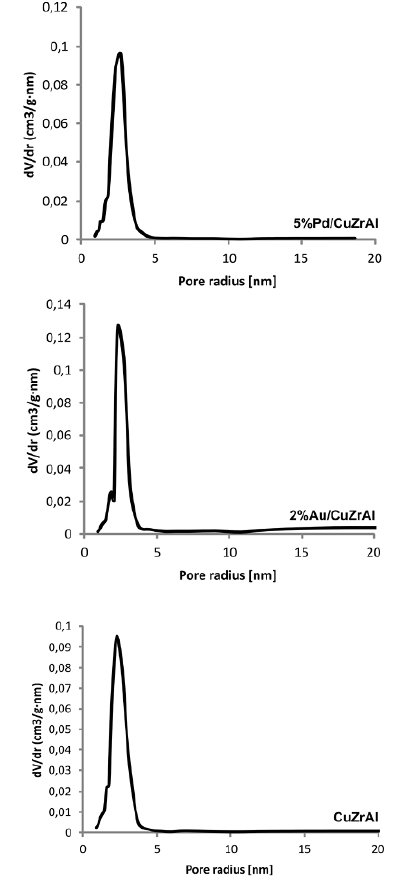
Figure 1. Pore size distribution for CuZrAl, 2%Au/CuZrAl and 5%